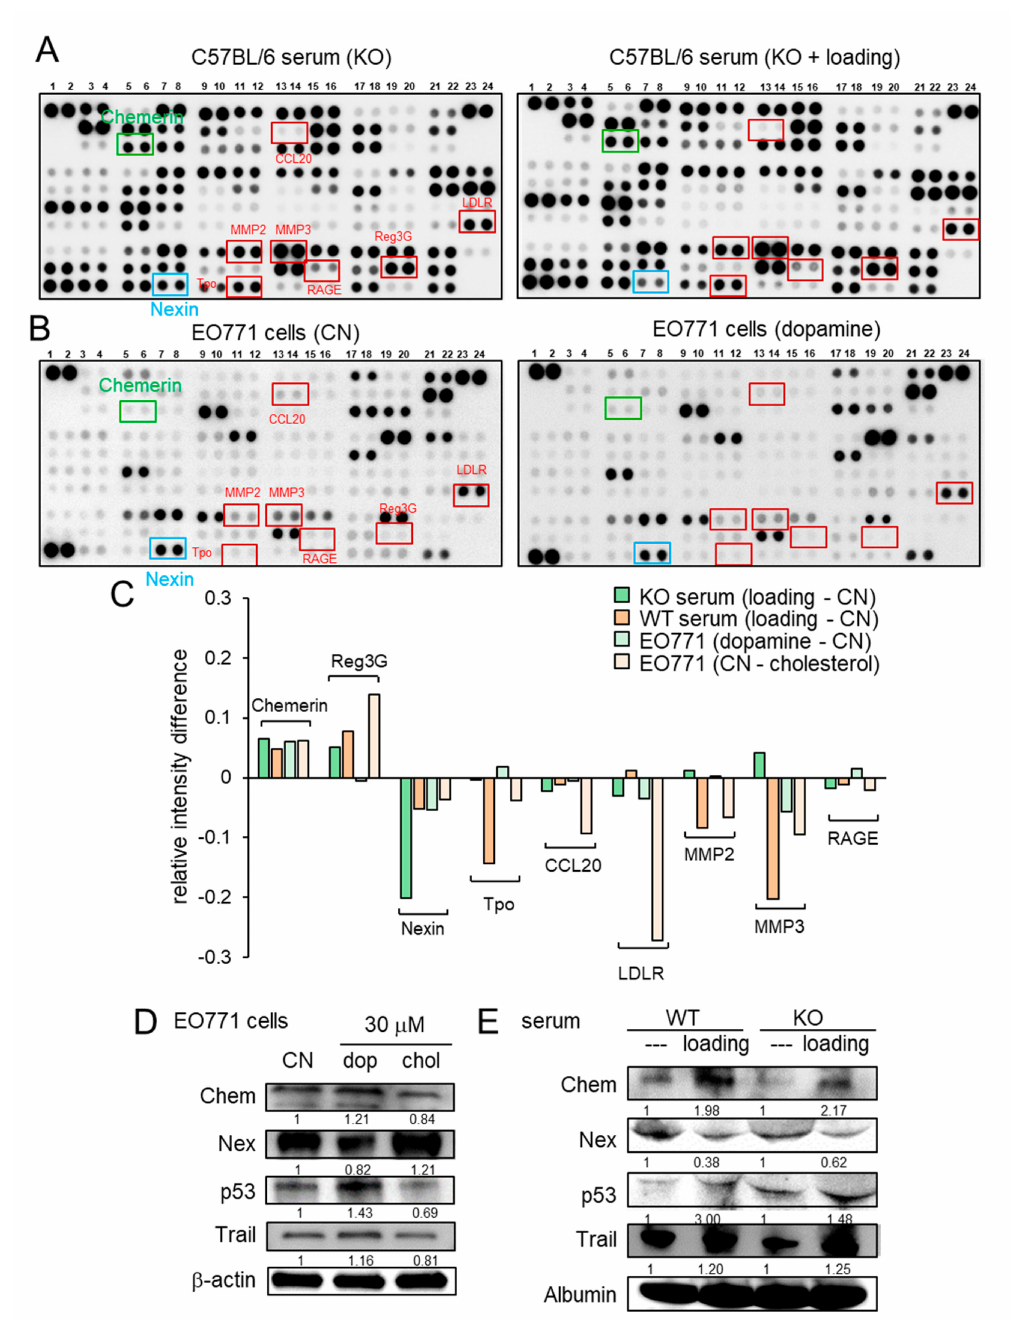
Figure 4. Cytokine array analysis using the serum and EO771 mammary tumor cells. WT = wild-type, KO = knockout, CN = control, dop = dopamine, chol = cholesterol, Chem = chemerin, and Nex = nexin. ( A ) Cytokine expression profile in the serum of knockout mice with and without knee loading. ( B ) Cytokine expression profile in EO771 cells with and without the administration of 10 µ M dopamine. ( C ) Summary of the cytokine expression profiles for four pairs of samples, including the sera from the wild-type and knockout mice, and EO771 cells treated with dopamine and cholesterol. ( D ) Expression of chemerin, nexin, p53, and TRAIL in EO771 cells in response to 30 µ M dopamine and cholesterol. ( E ) Expression of chemerin, nexin, p53, and TRAIL in the serum of the wild-type and knockout mice with and without knee